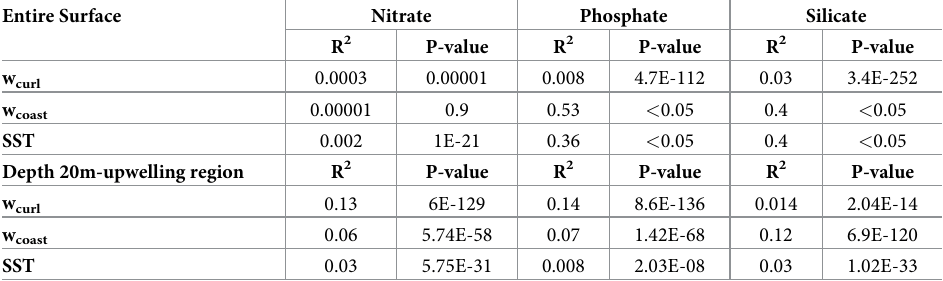
Table 4. Coefficient of determination (R 2 ) and its corresponding-significance test p-values, between all pairs of variables: Nutrients (nitrate, phosphate, silicate), vertical velocity of coastal upwelling (w curl ), vertical velocity of curl-driven upwelling (w coast ), sea surface temperature (SST) for: 1) the entire region of the Arabian gulf, 2) at depth of 20m of the upwelling region. Entire Surface Nitrate Phosphate Silicate